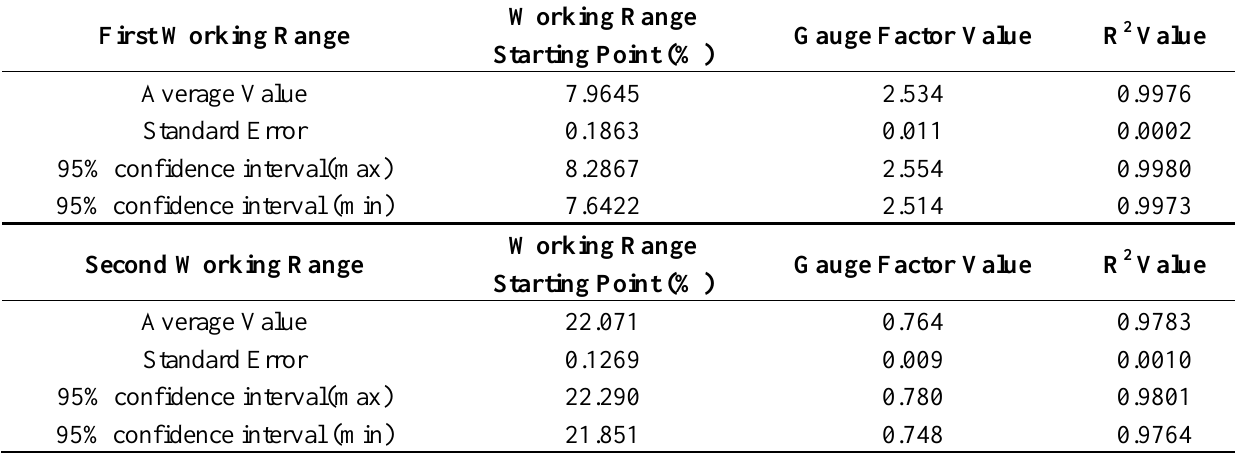
Table 8. Statistical results of samples with conductive yarn of 10 cN input tension .